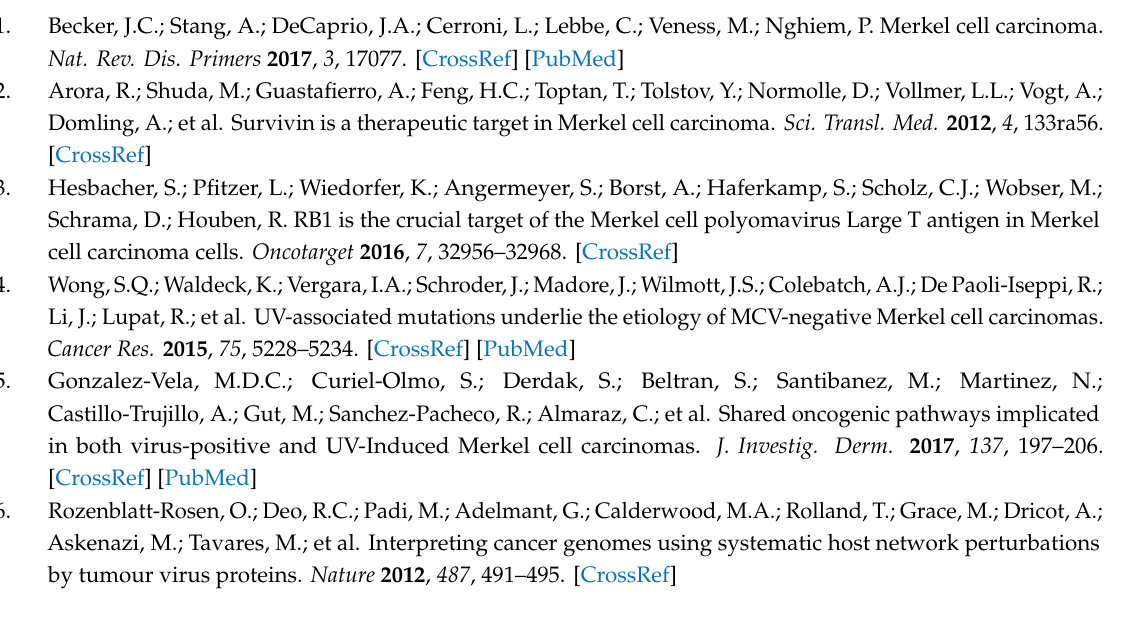
Figure S1: Expression of miR-375 and U6 in MCC cells transfected with antagomiRs, depicted in amplification curves, Figure S2: Relative expression of miR-375 in MCC cells transfected with antagomiRs, Figure S3: Apoptosis of MCC cells transfected with antagomiRs was determined in flow cytometry, Table S1: List of predicted miR-375 target genes in ENCORI, Table S2: Alteration of gene expression (Hippo and EMT related) after miR-375 knockdown in WaGa